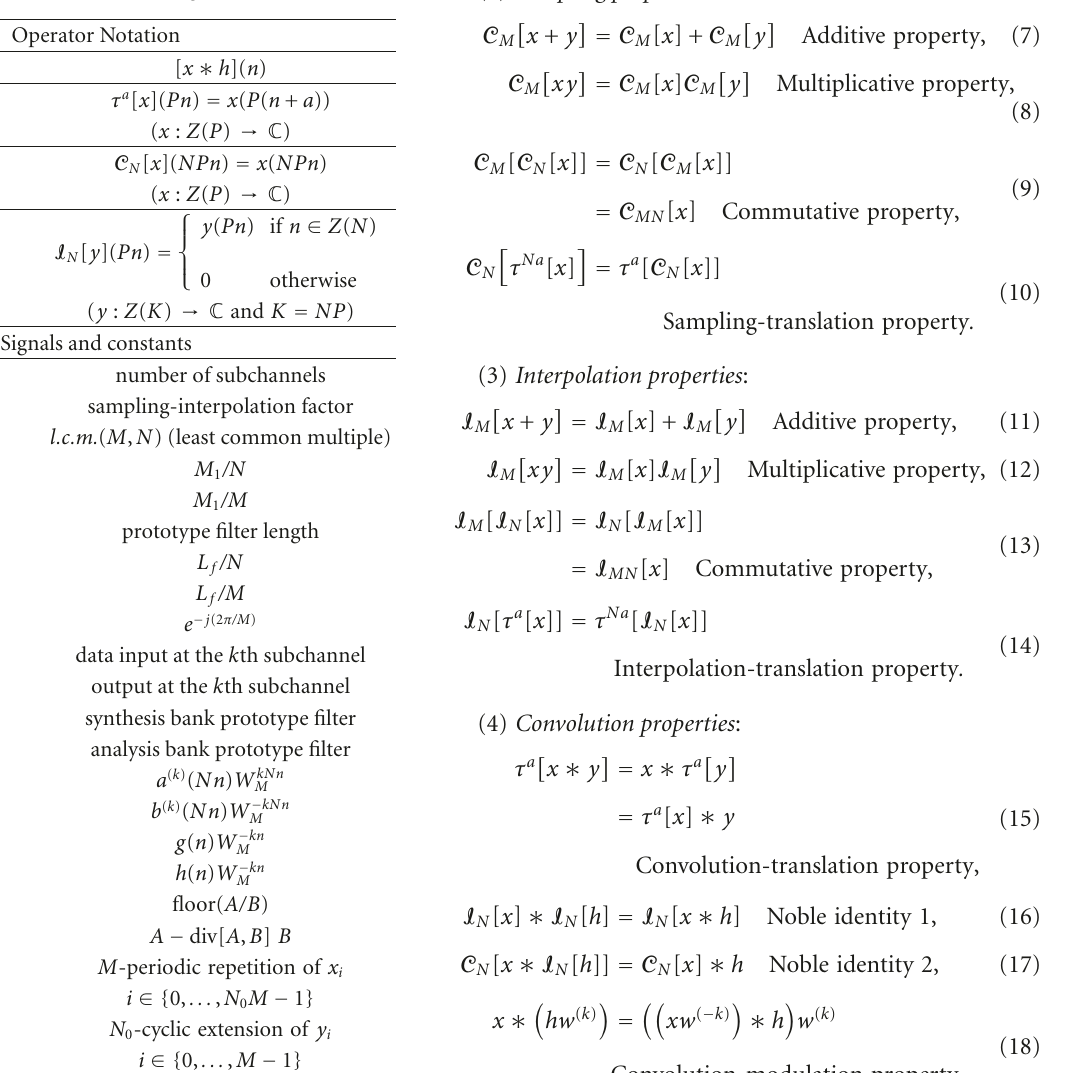
Table 1: Operator notation and useful signals and